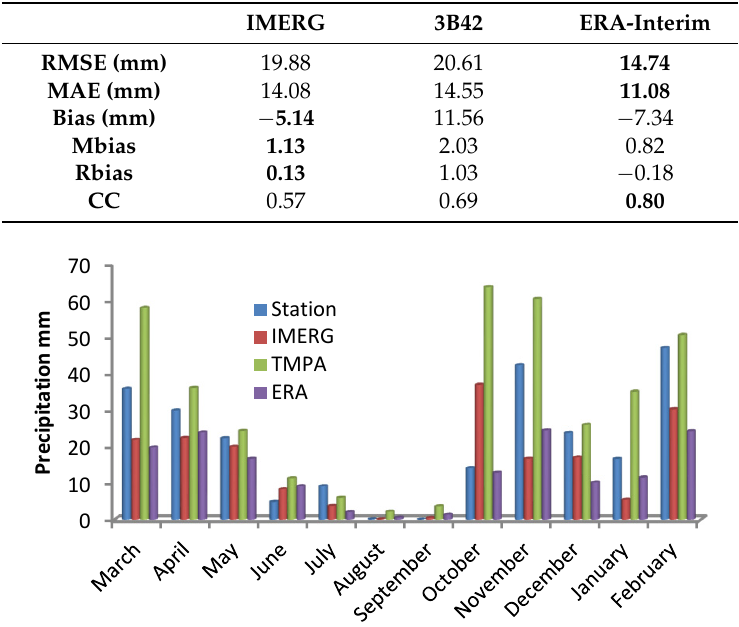
Figure 11. Tehran monthly precipitation (mid-March 2014 to February 2015).